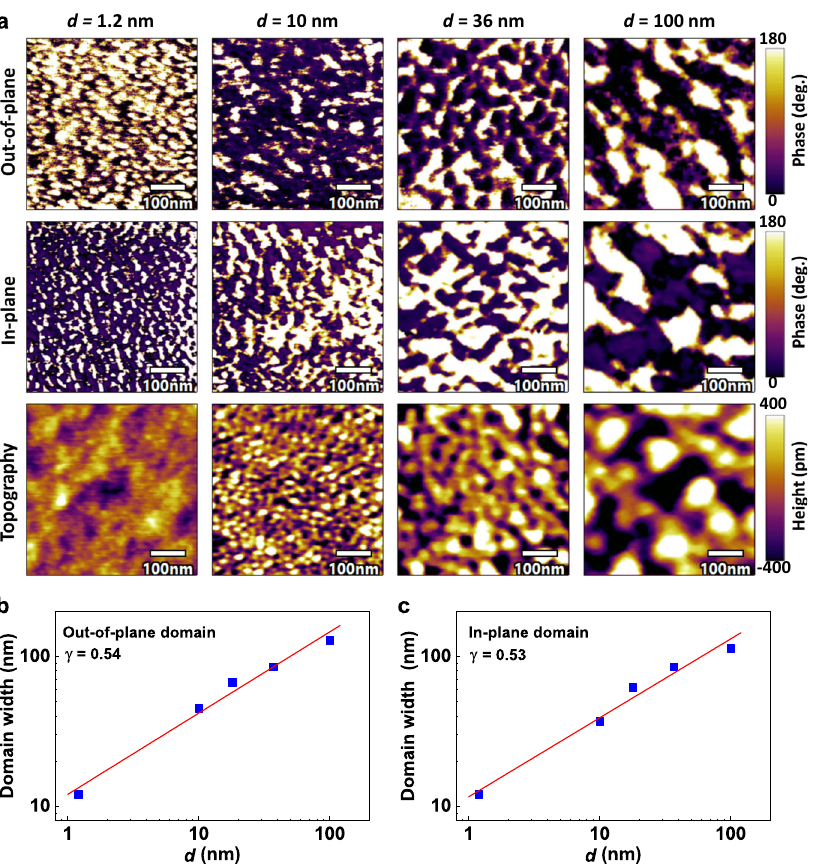
Fig. 2 Ferroelectric domain structures of (111)-oriented PZT fi lms with different thicknesses. a PFM out-of-plane and in-plane phases and topographies of PZT fi lms with different thicknesses. b , c Domain width versus fi lm thickness ( d ) for out-of-plane and in-plane, respectively. The solid lines are the fi tting results by a power